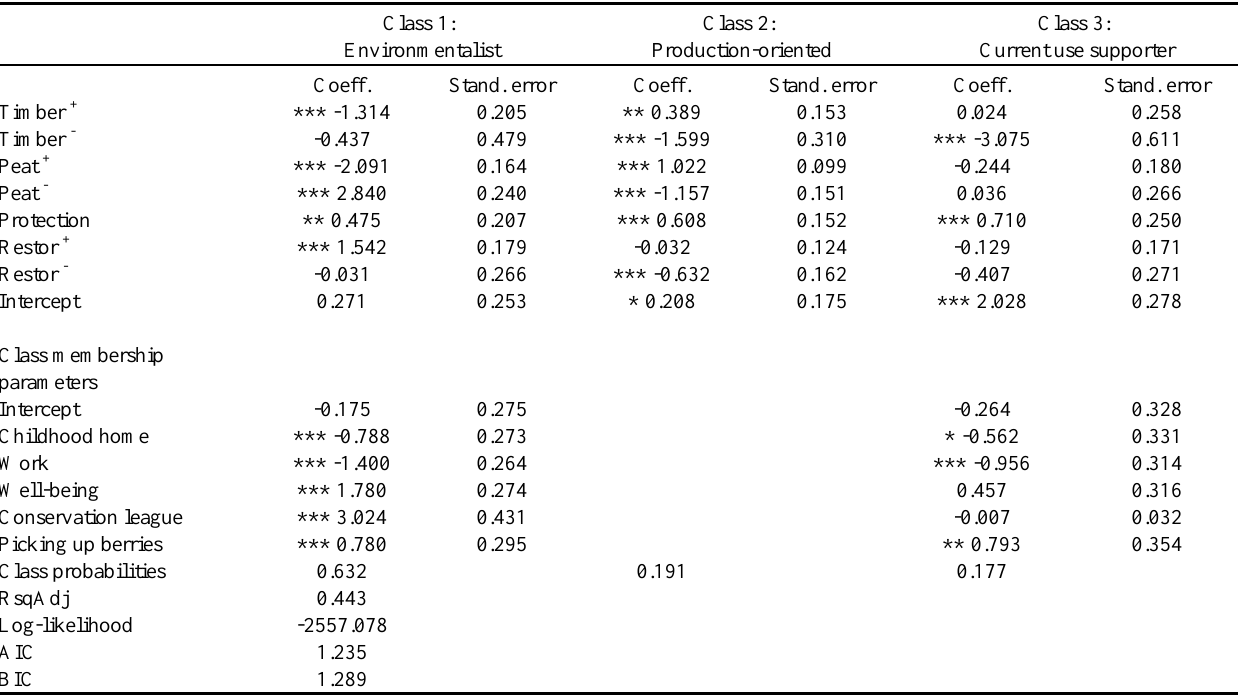
Table 6 . Results of the 3-class latent class model (LCM) including factors on the relationships of peatlands to respondents’ personal lives as explanatory variables for class membership. The class membership coefficients for Class 2 were fixed in order to identify the remaining coefficients. Number of respondents =